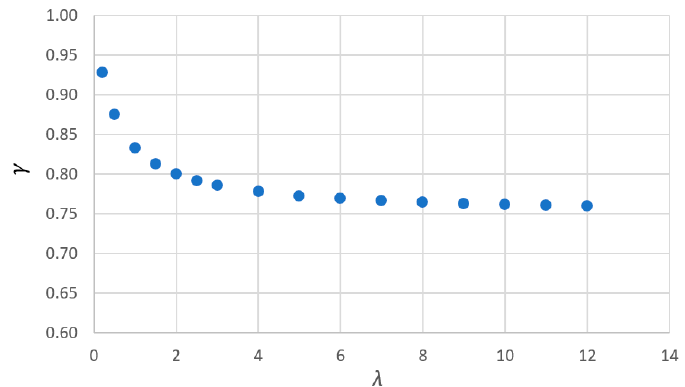
Figure 3. Parameter γ as a function of the index of pore size distribution λ between 0.2 and 12.